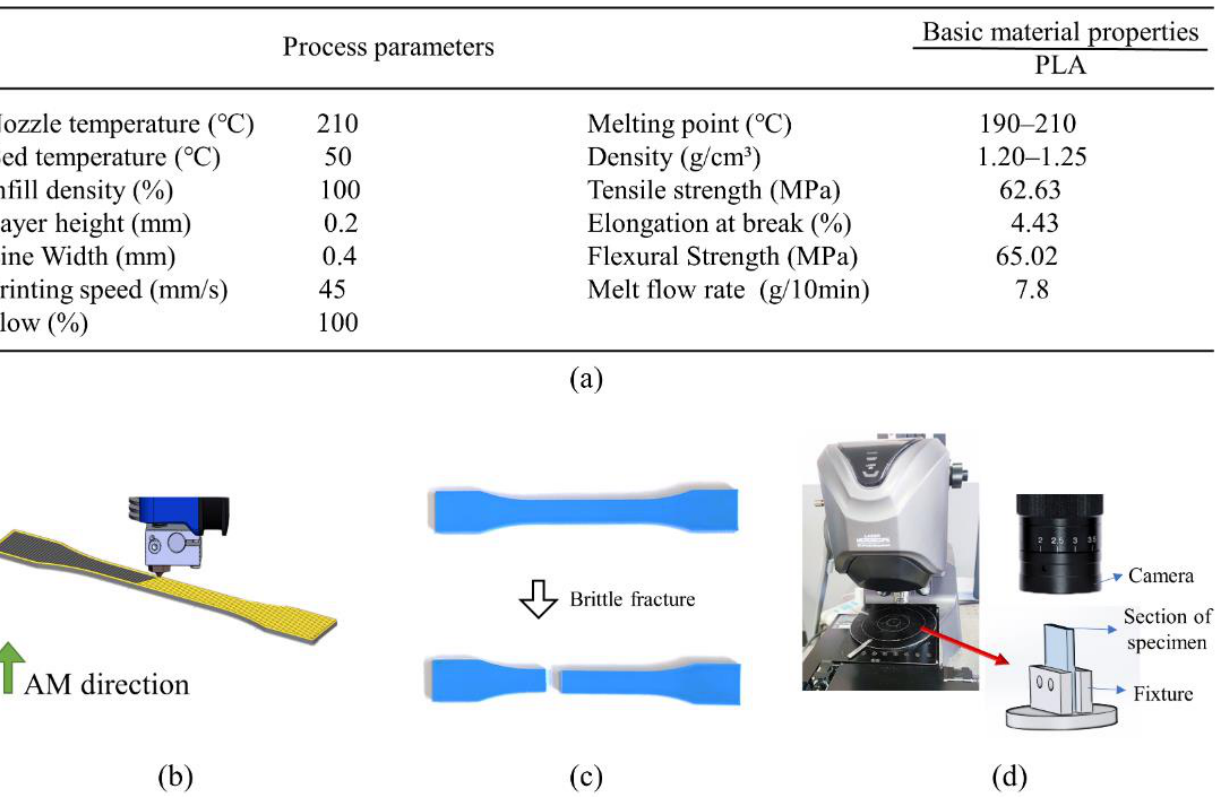
Figure 2. Preparation of the specimens: ( a ) printing process parameters and material properties, ( b ) printing setup of the specimens, ( c ) the additive manufacturing specimens, and ( d ) laser scanning microscopy.